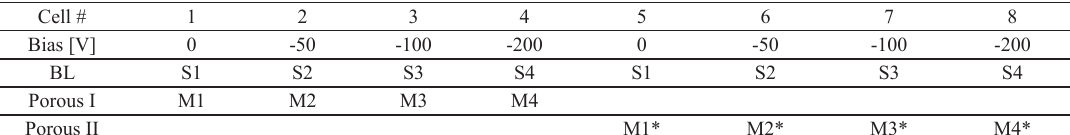
films used in Figures 5 to 10 and 2